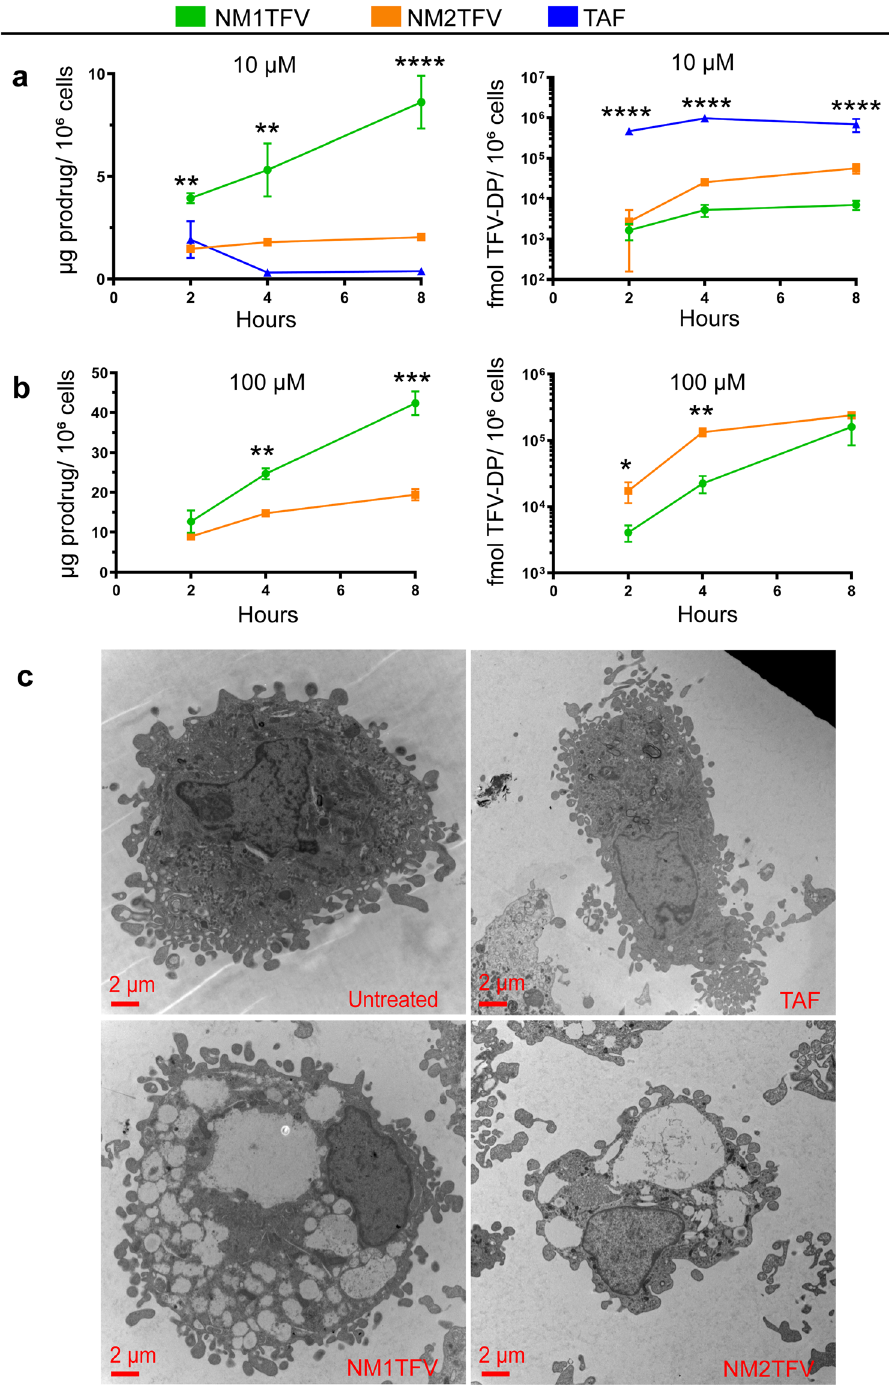
Fig. 3 Cellular uptake. Following a 10 µ M (** P = 0.0035, ** P = 0.0029, **** P <0.0001 NM1TFV vs. NM2TFV prodrug; **** P <0.0001 NM1TFV vs. TAF TFV- DP) or b 100 µ M treatments (** P = 0.0021, *** P = 0.0003 NM1TFV vs. NM2TFV prodrug; * P = 0.0273, ** P = 0.0022 NM1TFV vs. NM2TFV TFV-DP), intracellular prodrug (left) and TFV-DP (right) concentrations in MDM was measured over an 8h period. a , b Prodrug uptake of NM1TFV (green) signi fi cantly greater than NM2TFV (orange) and TAF (blue). TAF treatment resulted in the most rapid prodrug conversion to TFV-DP, followed by NM2TFV, and NM1TFV. a , b Values reported are the mean±SEM of three replicates. Each experiment was repeated independently three times with equivalent results. c Transmission electron microscopy (TEM) of control, TAF, NM1TFV, and NM2TFV loaded MDM after 8h drug incubation with 10 µ M drug. Scale bar: 2 μ m. For comparison of two groups Student ’ s t-test (two-tailed, unpaired) was used (* P ≤ 0.05, ** P <0.01, *** P <0.001, **** P <0.0001 NM1TFV compared with NM2TFV). A one-way analysis of variance (ANOVA) followed by Tukey ’ s post hoc test was used to compare the prodrug and TFV-DP levels among three treatment groups (* P ≤ 0.05, ** P <0.01, *** P <0.001, **** P <0.0001 NM1TFV compared with NM2TFV or TAF). Data were independently reproduced three times.